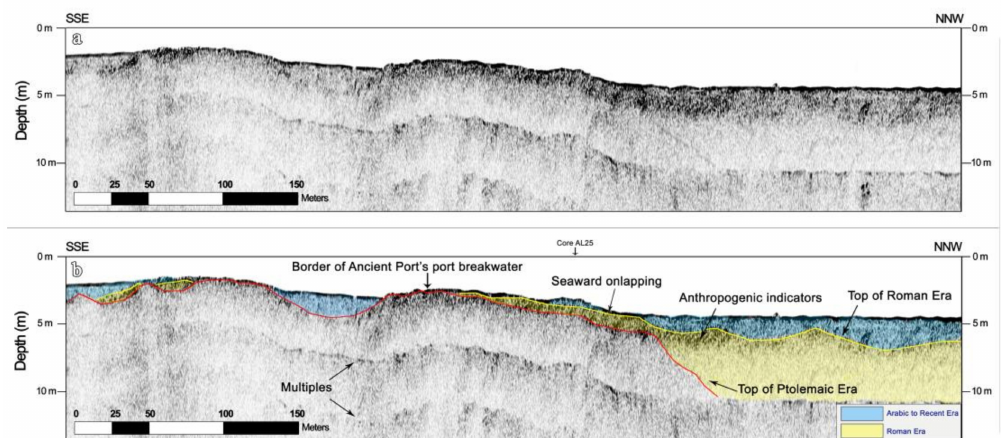
Figure 9. Seismic profile [C] across the Port side breakwater of the submerged ancient harbor. ( a ) Uninterpreted profile; ( b ) Interpreted profile.